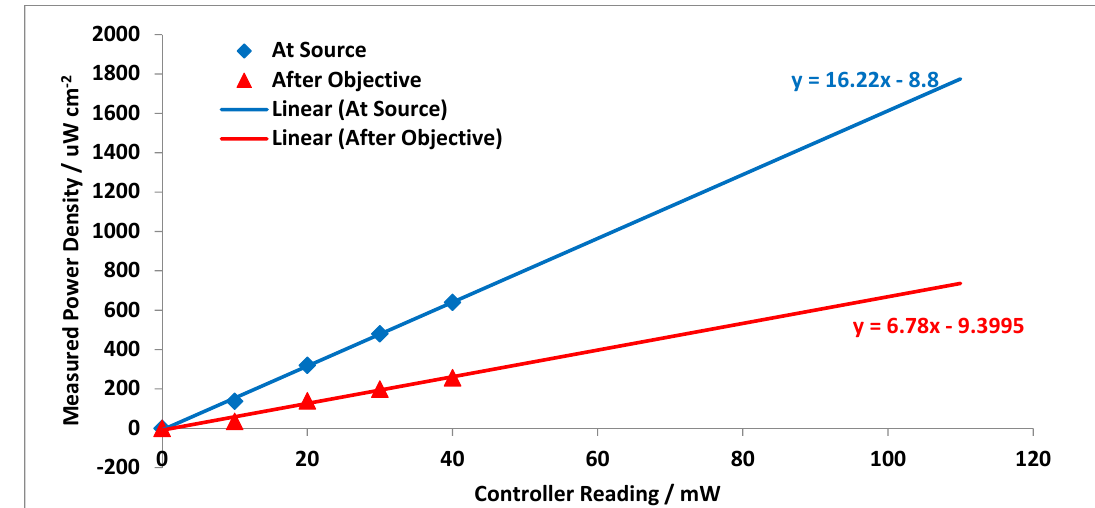
Figure A4. Relative power of the Raman laser at source and at the sample stage.